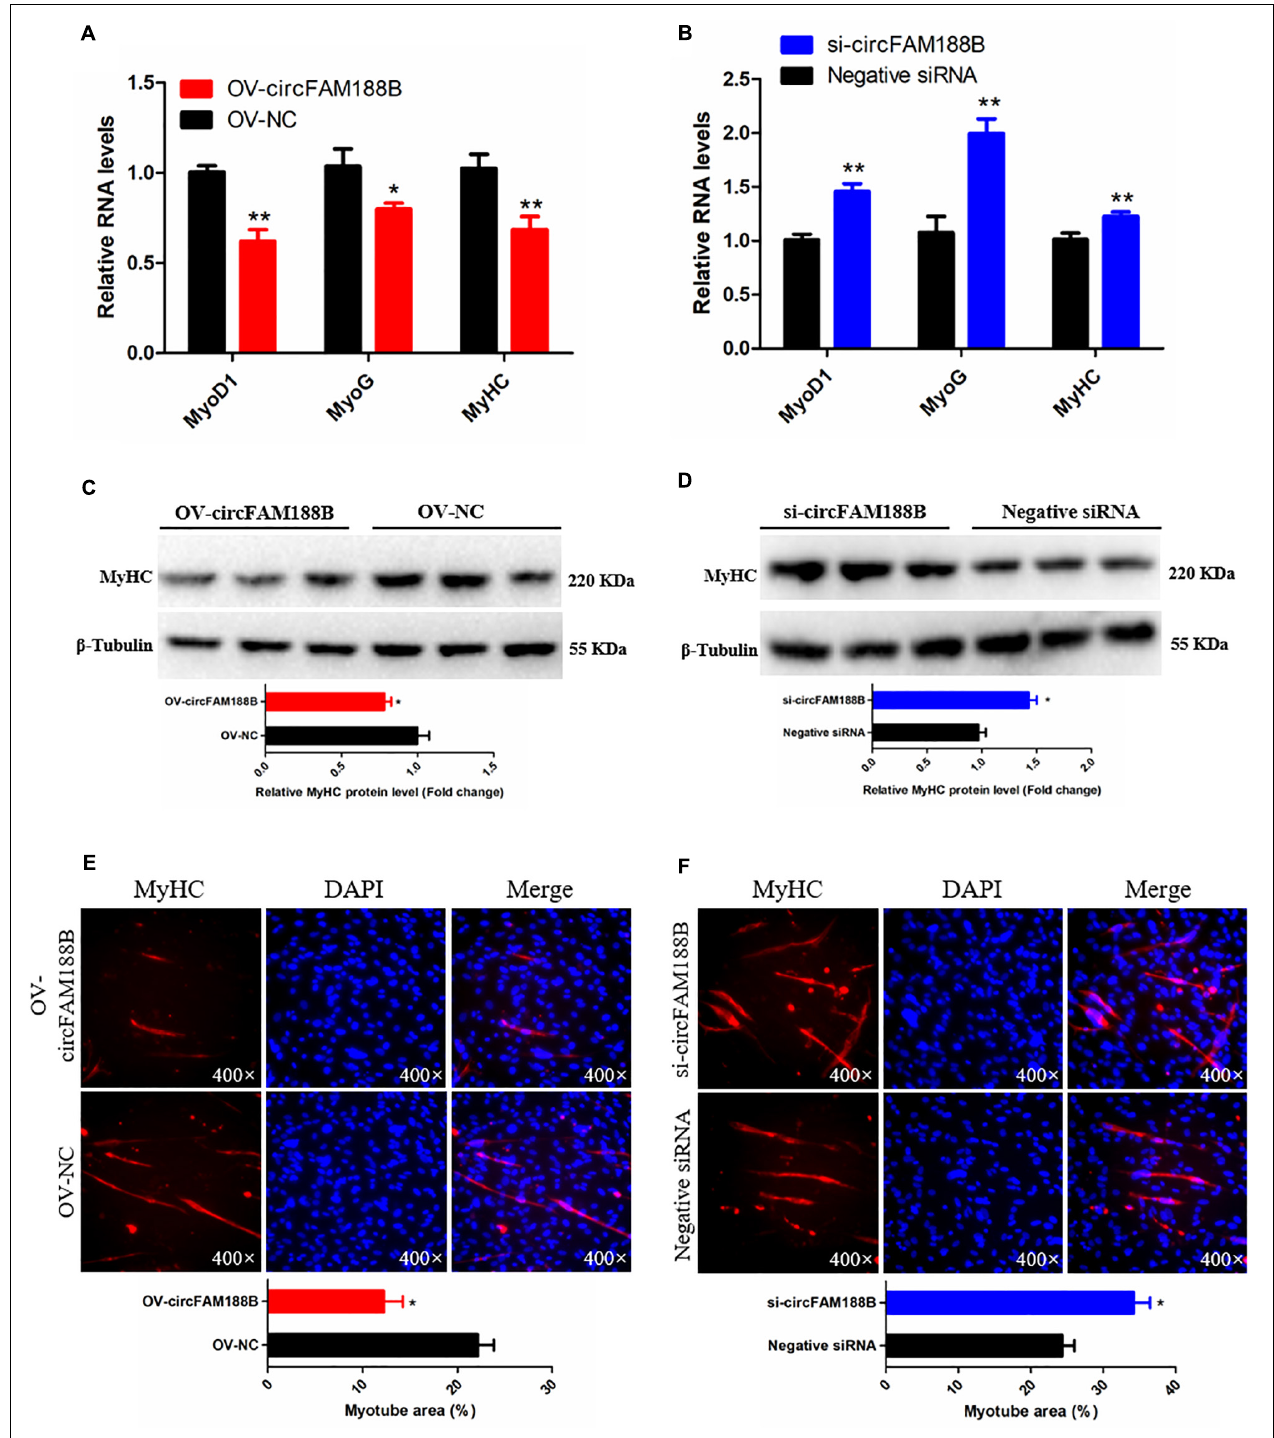
FIGURE 3 | CircFAM188B inhibits chicken SMSC differentiation. (A,B) The relative RNA level of muscle cell differentiation marker genes in chicken SMSCs following circFAM188B overexpression or inhibition. (C,D) The levels of MyHC and β -tubulin proteins in SMSCs following circFAM188B overexpression or inhibition (upper panels) . MyHC band intensities quantified by Image J and normalized against β -tubulin (lower panels) . (E,F) Images of MyHC staining of SMSCs following circFAM188B overexpression or inhibition (upper panels) . Relative myotube area (ratio of MyHC fluorescence area to DAPI area) of SMSCs following circFAM188B overexpression or inhibition (lower panels) . The results of all groups are shown as mean ± S.E.M., and the data represent three independent assessment methods. Student’s t -test was used to compare expression levels or values among different groups. * P < 0.05; ** P < 0.01.